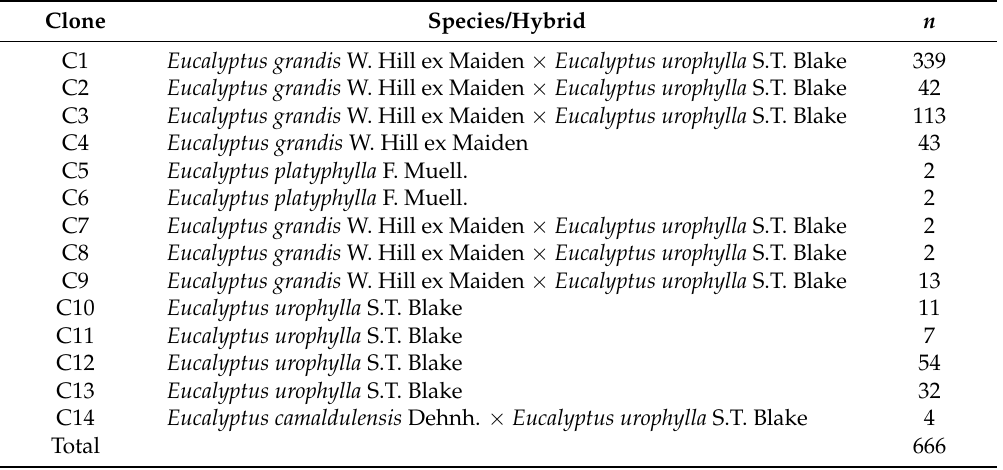
Table A1. Description of species and hybrids for each clone of Eucalyptus.